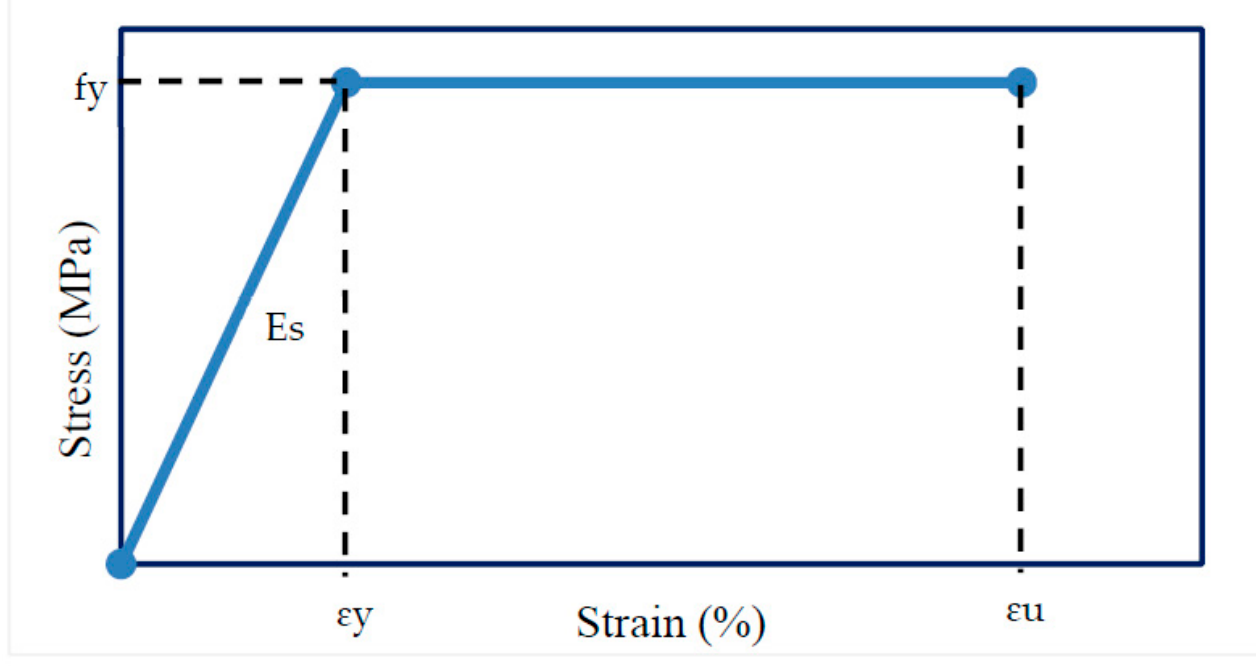
Figure 4. Typical stress-strain curve of CFS.